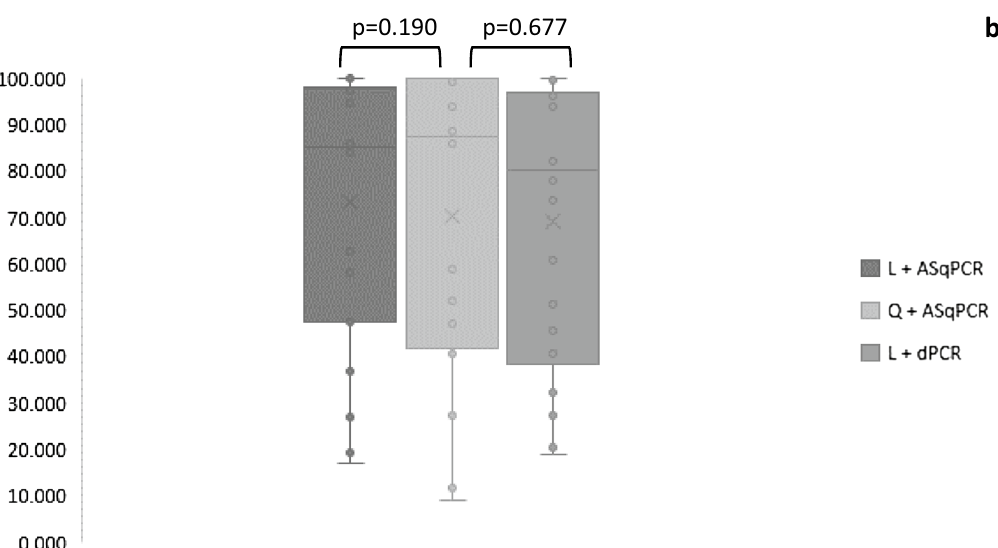
Figure 4. Comparison of cytb A143 frequency results of samples from Tasmania. Q + ASqPCR—crude DNA + ASqPCR, L + ASqPCR—Lab DNA + ASqPCR, L + dPCR—Lab DNA + dPCR. ( a ) Individual sample results 1A-1F and 2A-2F—samples collected from sites 1 and 2 in the Table Cape region; 3A-3E and 4A-4E— samples collected from sites 1 and 2 in the Midlands region. Error bars show standard error of mean of triplicates. ( b ) Box plots of average results for each analysis type and paired t test. Boxed area represents the inter-quartile range, horizontal line within box represents the median, x represents the